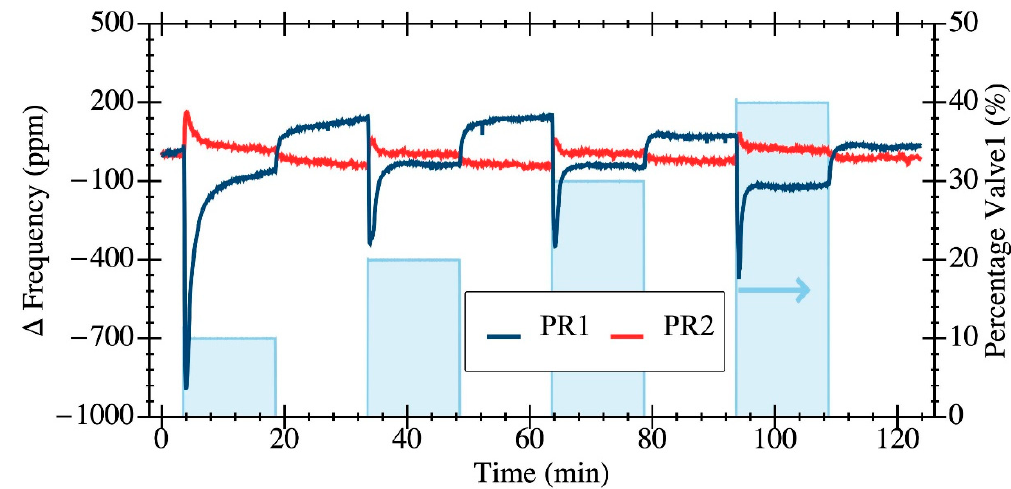
Figure 7. Time evolution of relative frequency change measured at the self-sustained oscillator output plate resonators: PR1 (blue line) and PR2 (red line) for a total dry air flow of 300 mL·min − 1 . Two valves were complementary switching their relative aperture (the % of valve 1 is depicted in light blue) to test the impact of an overall flow transient spike on the resonator frequency.